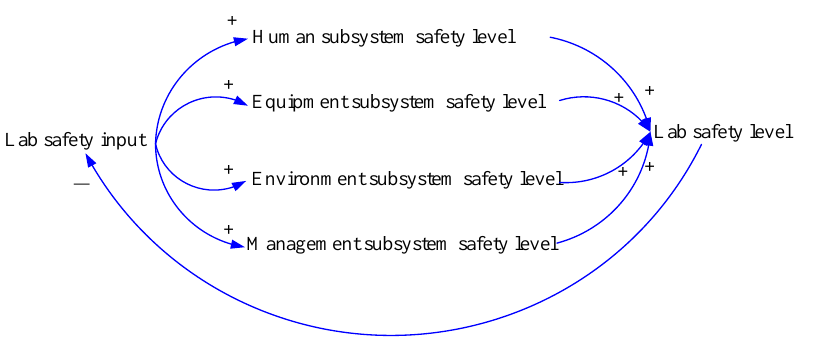
Figure 5. Causal loop of the laboratory safety management process.